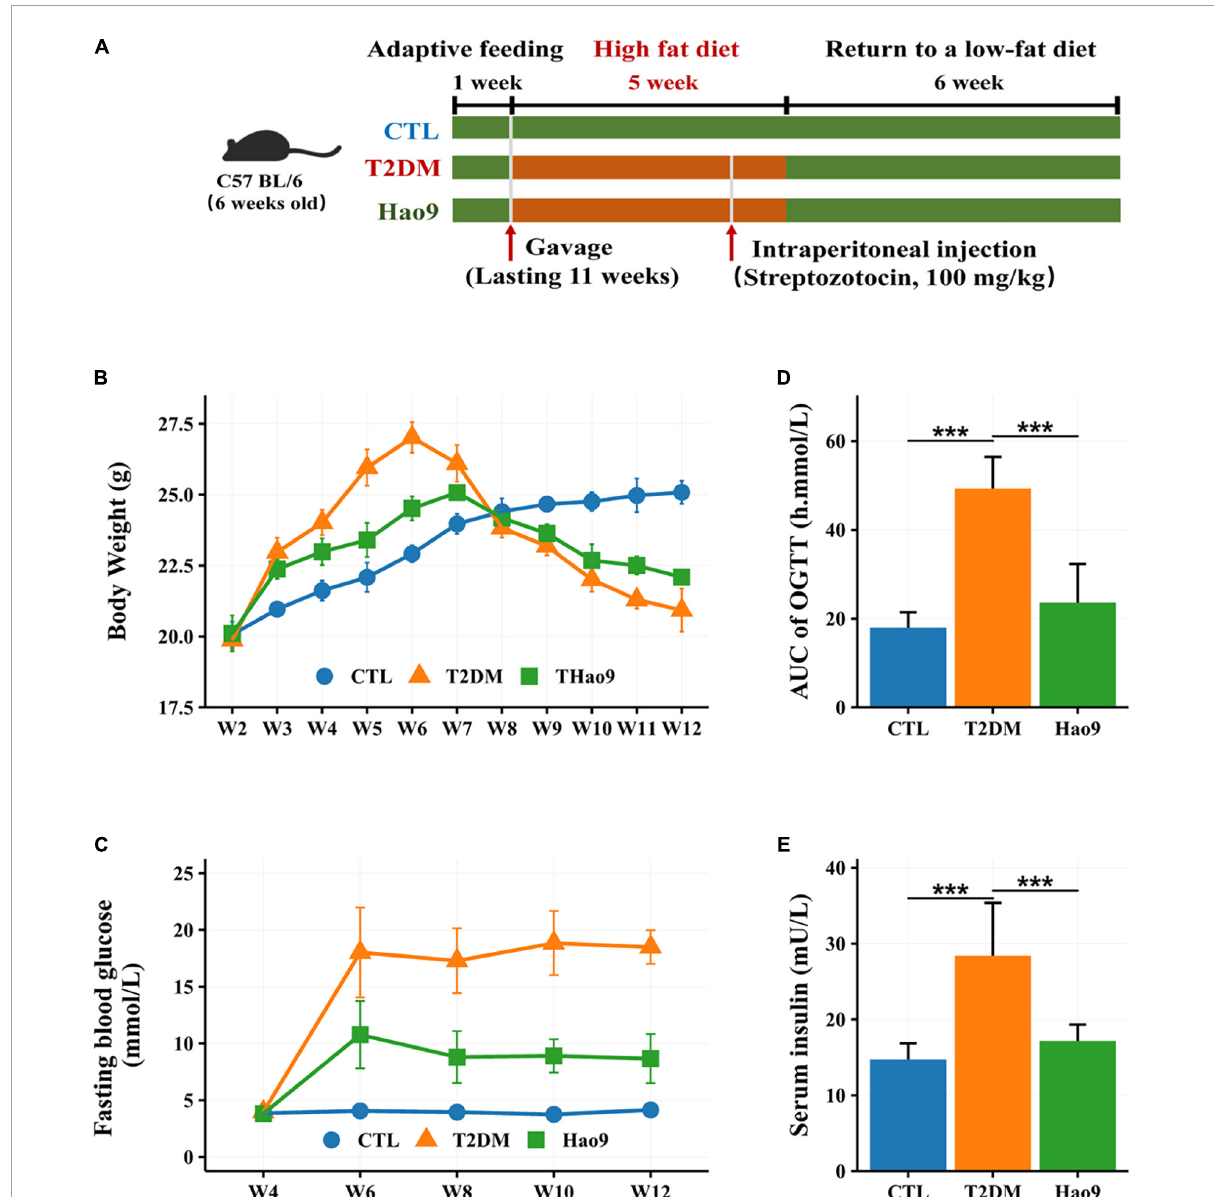
FIGURE1 The experimental design of mice exposure to high fat diet (HFD) and streptozotocin (STZ) and treated with L. rhamnosus Hao9 (A) . The effect of Hao9 on body weight (B) , fasting blood glucose (C) , oral glucose tolerance (D) , and serum insulin levels (E) in HFD + STZ-induced diabetic mice. In bar plots (D,E) we used mean ± standard deviation (SD) to describe differences between groups and *** p <